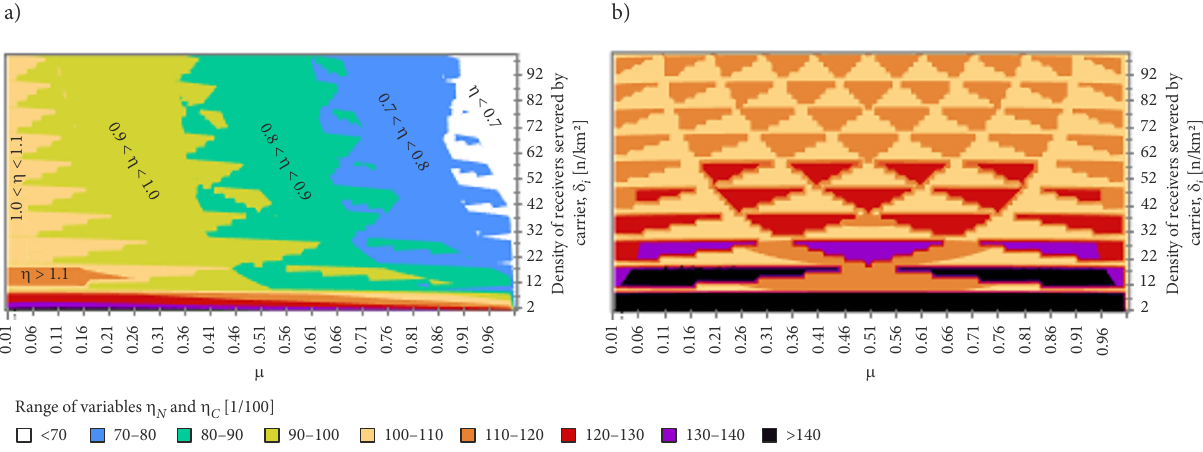
Figure 3. Results in Scenario 1.1 ( C N = 9 m 3 ): a – h N ratio; b – h E ratio